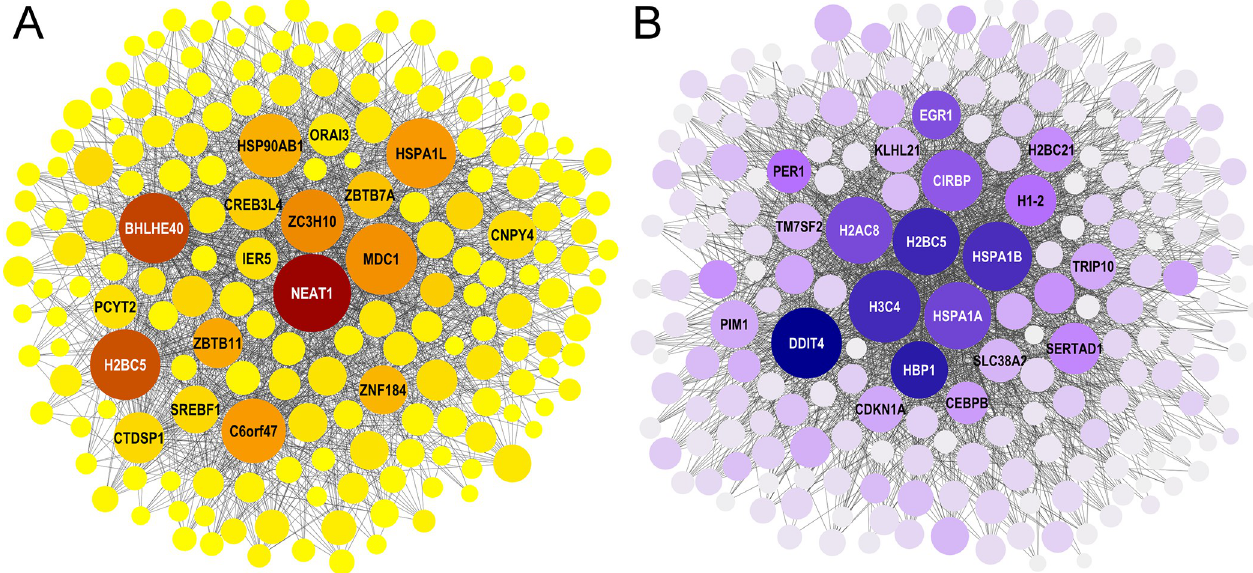
Fig 9. Interaction networks generated from Gene Sets 1 and 2. Node size represents degree centrality (i.e., increasing size represents greater numbers of edges intersecting the node) whereas color gradient represents betweenness centrality (i.e., increasing color depth represents greater numbers of shortest paths passing through the node). Networks filtered to top 20 nodes by degree and nearest neighbors for simplicity (but all nodes are listed in Tables H and I in S1 Data). ( A ) Contrasting Gene Set 1 seeded network. NEAT1 , a long noncoding RNA, was the most central node by both degree and betweenness criteria. ( B ) Parallel Gene Set 2 seeded network. Target genes DDIT4 , HSPA1A , HSPA1B , and several histone genes were the most central nodes.